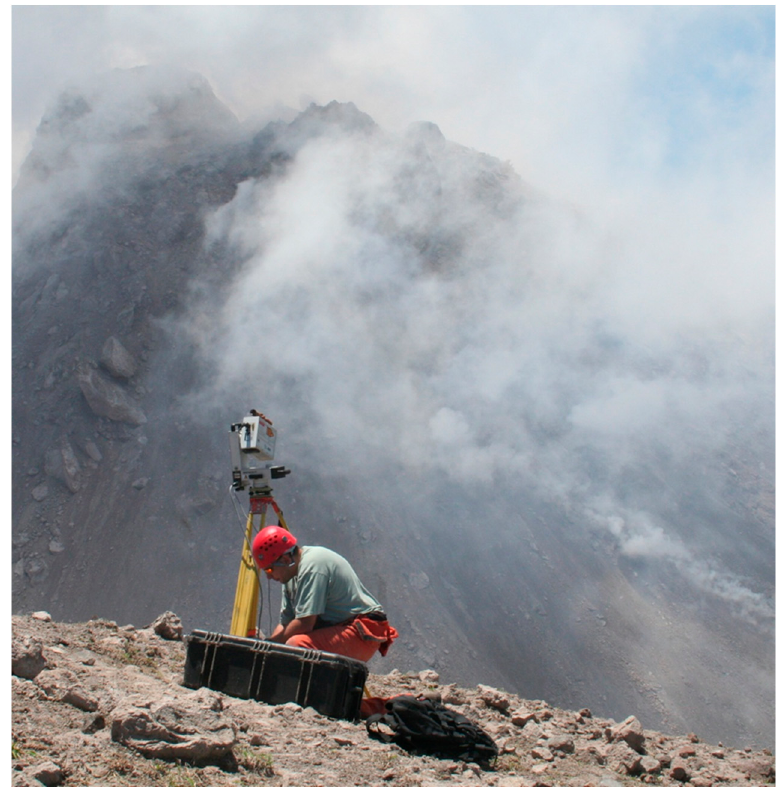
Figure 11. Scanning the active lava dome of the Soufrière Hills Volcano, Montserrat.